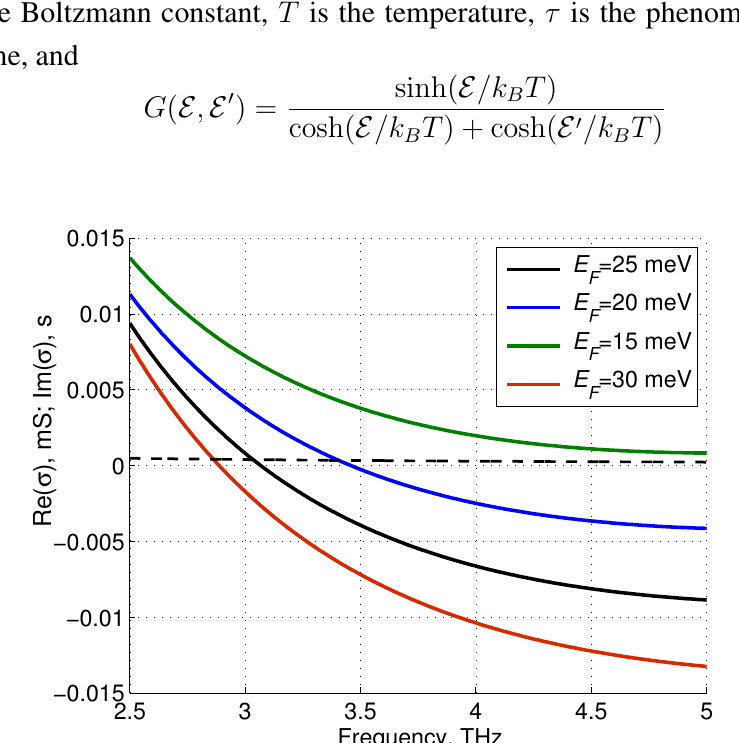
Figure 2. Real part of the dynamic conductivity, calculated for different E of σ calculated at E = 25 meV, is shown by the dashed F